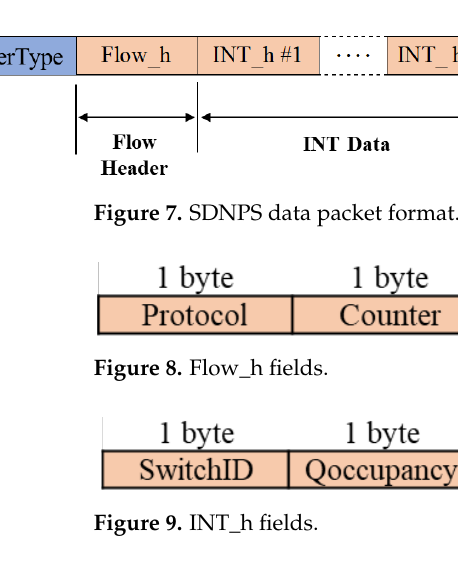
Figure 9. INT_h fields.